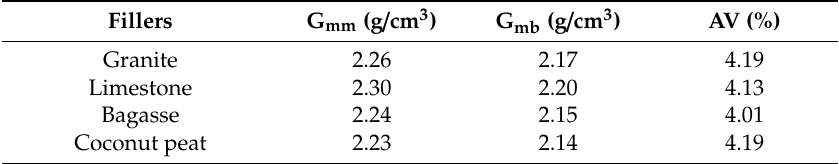
Table 6. The volumetric designs for granite, limestone, bagasse and coconut peat